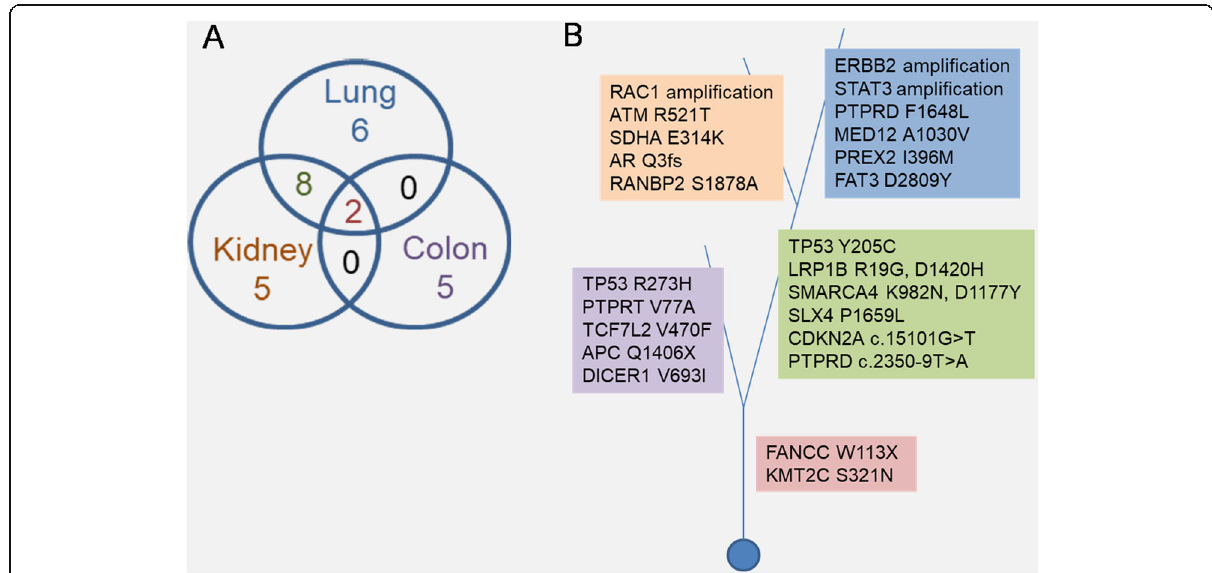
Fig. 2 Mutations detected among the lung, kidney and colon tumors. a Venn diagram illustrating the number of shared and specific mutations among the tumors. b Cladogram illustrating the mutations shared and distinct to each of the tumors. Shading in pink denotes mutations shared among the three tumor samples; Green for mutations shared between the lung and kidney samples; Blue for lung-specific mutations; Orange for kidney-specific mutations and Purple denotes colon-specific mutations